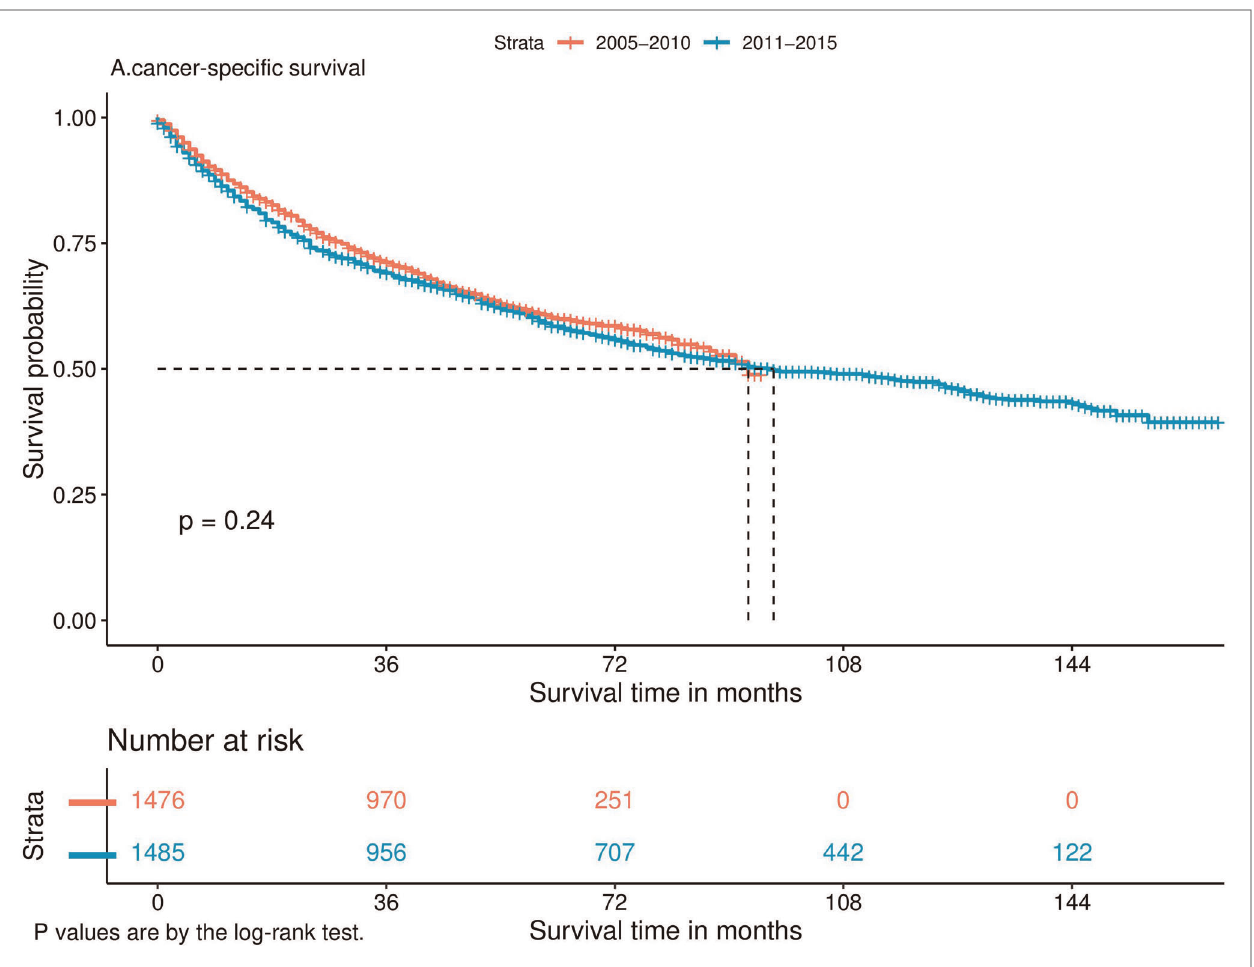
FIGURE 7 | Kaplan-Meier